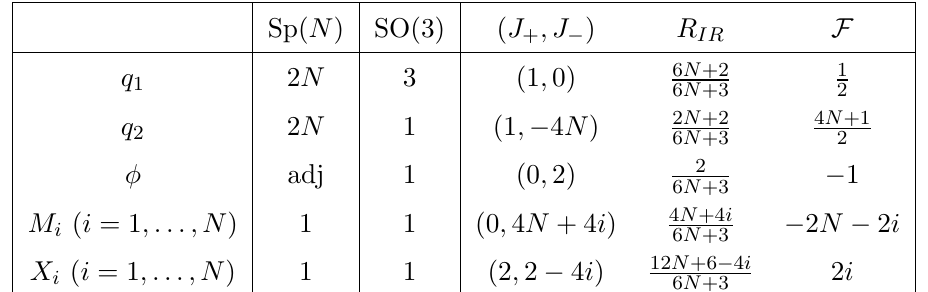
Table 4 . Matter content of the N = 1 gauge theory (cid:13)owing to the ( A 1 ; D 2 N +1 ) theory. The superconformal R-charge is given by R IR = R 0 + (cid:15) F in terms of the IR data, with (cid:15) determined via a -maximization. By doing so, we obtain (cid:15) = 6 N +1 . The last column denotes the superconformal 6 N +3 R-charge at the IR (cid:12)xed